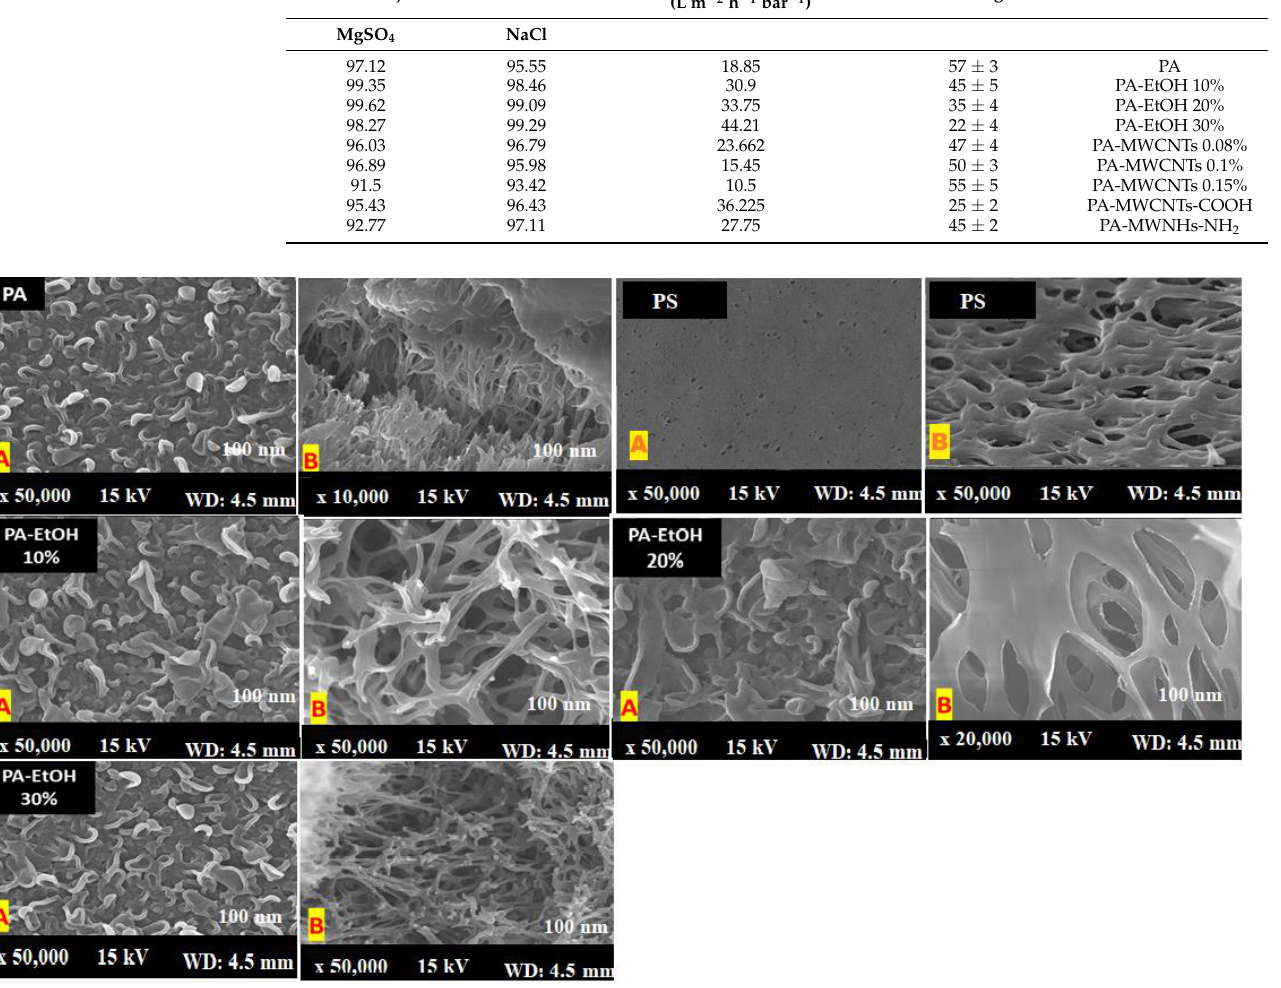
Table 1. Contact angle, water permeability, and salt rejection results of all membranes. Salt Rejection at 15 bar (%)